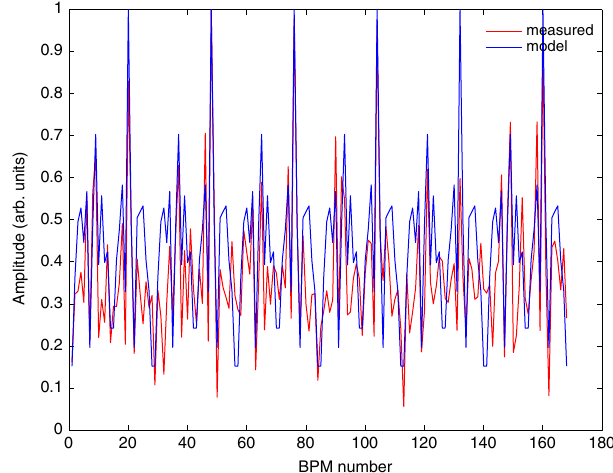
FIG. 5. (Color) Comparison of the amplitude of the ð(cid:1) 2 ; 0 Þ line in the horizontal plane. The spectral line from the model is blue while the measured one is in red.